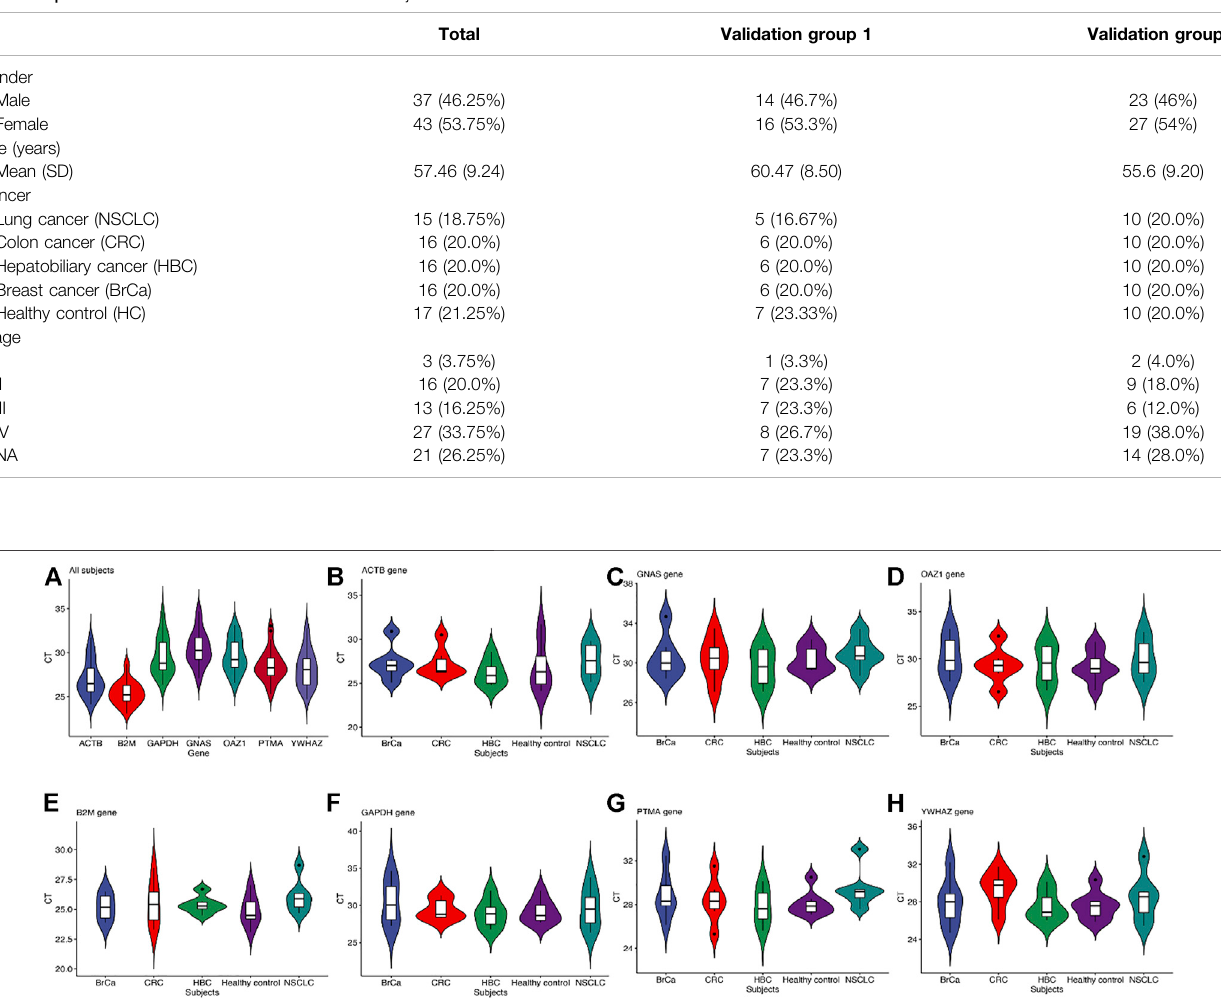
FIGURE 4 | (A) Validation of the stability of the seven reference genes. (B-H) The validation of each reference gene with the cancerous and health group. CT value re fl ectstheabundanceofreferencegeneexpression.ThehighertheCTvalue,thelowertheexpressionlevel,and viceversa .Thestandarddeviation(SD)ofCTvaluesisa schematic indicator of the stability of candidate reference gene expression in all the tested samples. The box plots show a box from the fi rst quartile (25th percentiles) to the third quartile (75th percentiles) and the median in the midst (50th